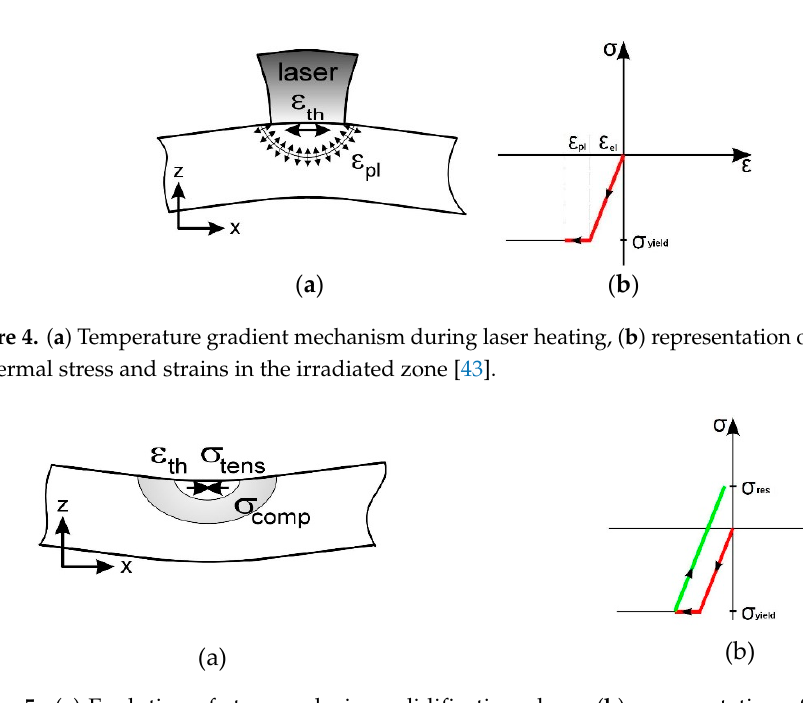
Figure 5. ( a ) Evolution of stresses during solidification phase, ( b ) representation of the evolution of residual stresses and strain in the irradiated zone [43]. Reused under Creative Commons Attribution License.